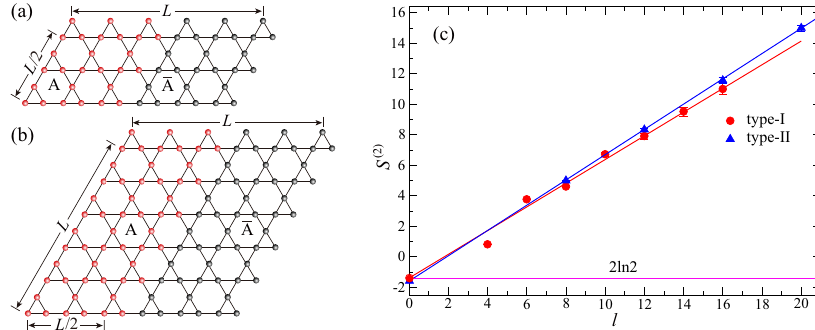
Fig. 4 Results of TEE for Z 2 quantum spin liquid. The second Rényi entanglement entropy of the 2D Kagome Z 2 QSL model in Eq. (6) for different aspect ratios, with the torus geometry of size L ´ L in ( a ) and L × L in (b), J ± / J z = 0.0625 (inside the QSL phase) and 1/ T = 480 (below 2 ´ L cylinder in ( a ) and L ´ L cylinder in ( b ), which is half of the system without the anyon gaps). The entangling region A is chosen to be a L 2 2 2 corners. Therefore the entanglement entropy is expected to only have area law contribution plus a constant γ -- the topological entanglement entropy. c For the Z 2 QSL state on Kagome lattice with torus geometry, the γ ¼ 2ln ð 2 Þ signifying the fractionalized statistics of the topological ordered QSL state. Our fi tting results with L = 12, 14, 16 in type-I geometry ( a ) and L = 6, 8, 10 in type-II geometry ( b ), give rise to γ = 1.4(2). SEM is used when estimating the errors of the physical